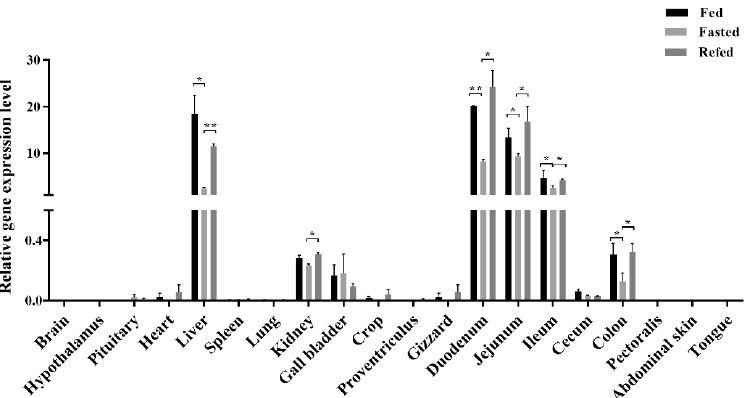
Figure 2. Relative expression levels of LEAP2 in the 20 tested tissues of chicks with different energy states (fed, fasted, and refed). GAPDH and HPRT were used as housekeeping genes to calculate the relative gene expression level. Error bars indicate the SE (n = 6). * indicates significant differences ( p ≤ 0.05), ** indicates significant differences ( p ≤ 0.01). Abbreviation: LEAP2, liver enriched antimicrobial peptide 2.